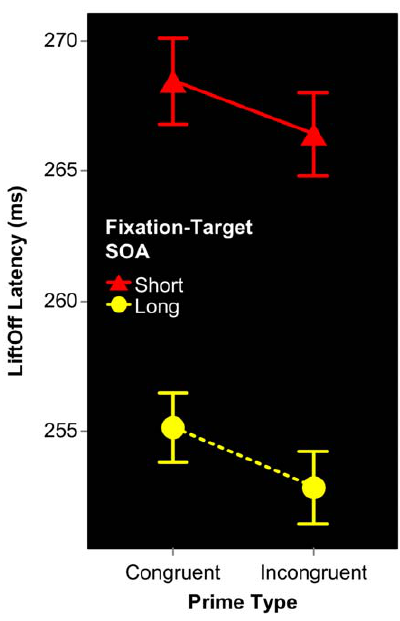
Figure 5. Conditional mean LiftOff Latencies for Expt 1B. Temporal attention modulates LiftOff Latency, in that subjects began their reaching movements earlier when Fixation-Target SOA was long. In contrast, the effect of Prime Type on LiftOff Latency was